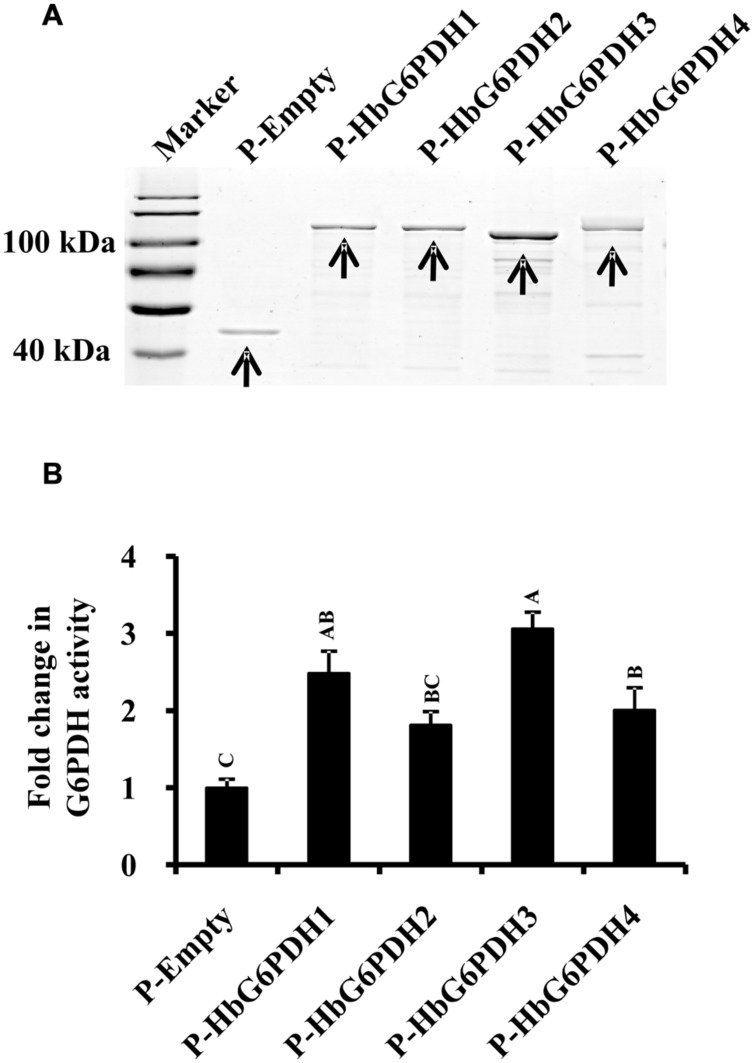
Expression of the four HbG6PDH genes in Escherichia coli. (A) Sodium dodecyl sulfate-polyacrylamide gel electrophoresis (SDS-PAGE) profile of protein extracts from ITPG-induced E. coli cells harboring the pMAL-c5E-Empty and pMAL-c5E-HbG6PDHs (HbG6PDH1 to 4). The arrowheads showed the protein bands of maltose binding protein (MBP) (P-Empty) and MBP-HbG6PDH fusions (P-HbG6PDH1 to 4). (B) Enzyme activity of the recombinant HbG6PDH proteins from pMAL-c5E-Empty and pMAL-c5E-HbG6PDHs (HbG6PDH1 to 4).